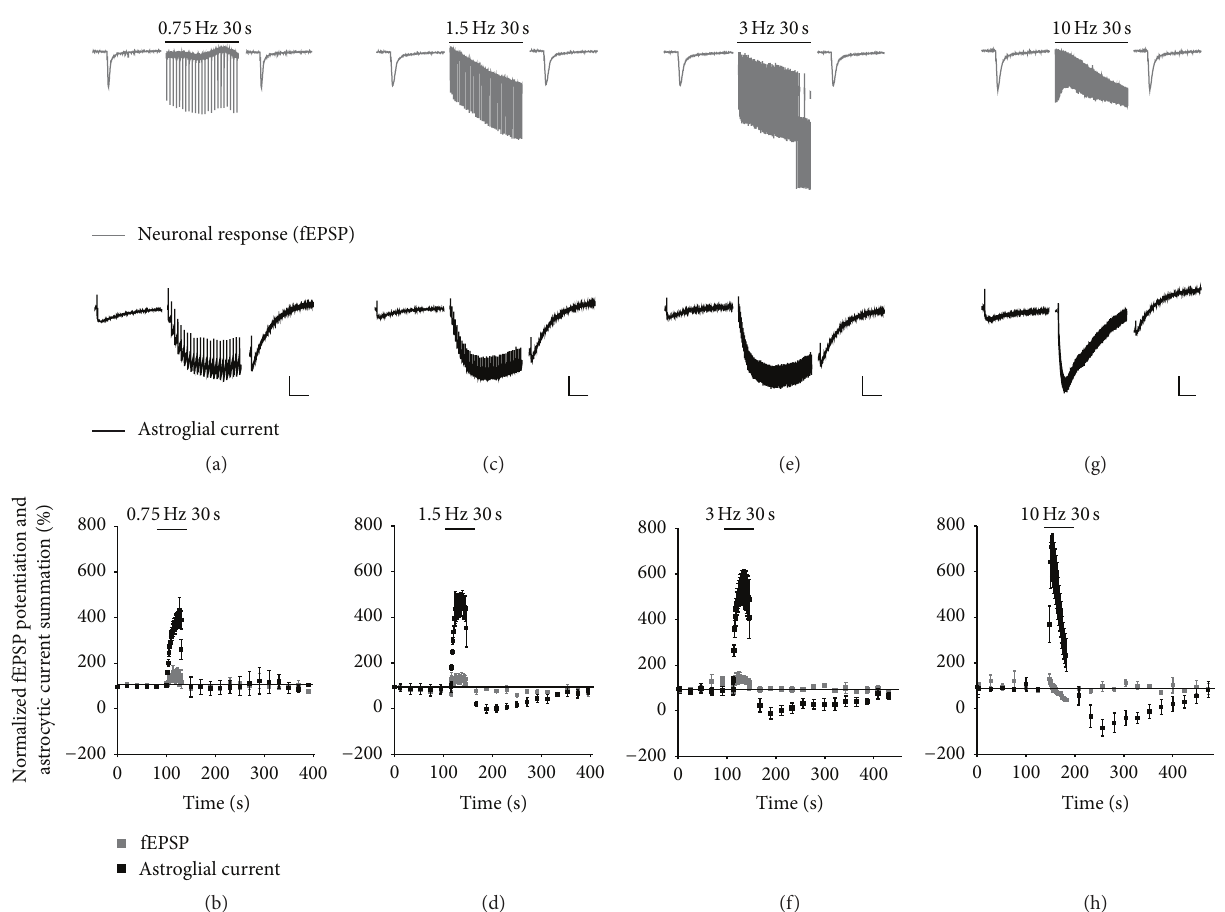
Figure 3: Short-term summation of astroglial currents compared to neuronal response during low frequency stimulations. Simultaneous recordings of field excitatory postsynaptic potentials (fEPSPs) and synaptically evoked astroglial currents were carried out in hippocampal CA1 region upon stimulation of Schaffer collaterals. (a, c, e, and g) Sample traces are shown for fEPSPs (top, gray) and astrocytic currents (bottom, black) in response to 30 s stimulations at indicated frequencies (0.75 to 10 Hz). Scale bars = 0.2 mV for fEPSP, 20pA for astroglial currents; 4 s for baseline, 5s during stimulations. (b, d, f, and h) Quantifications using astroglial summation method (see Figure 2) are shown for normalized fEPSP slope (gray) and astrocytic current amplitudes (black) in response to 30 s stimulations at indicated frequencies (0.75 to 10Hz). Stimulations are denoted by bars above traces or quantifications. Mean ± SEM are shown for (b), (d), (f), and